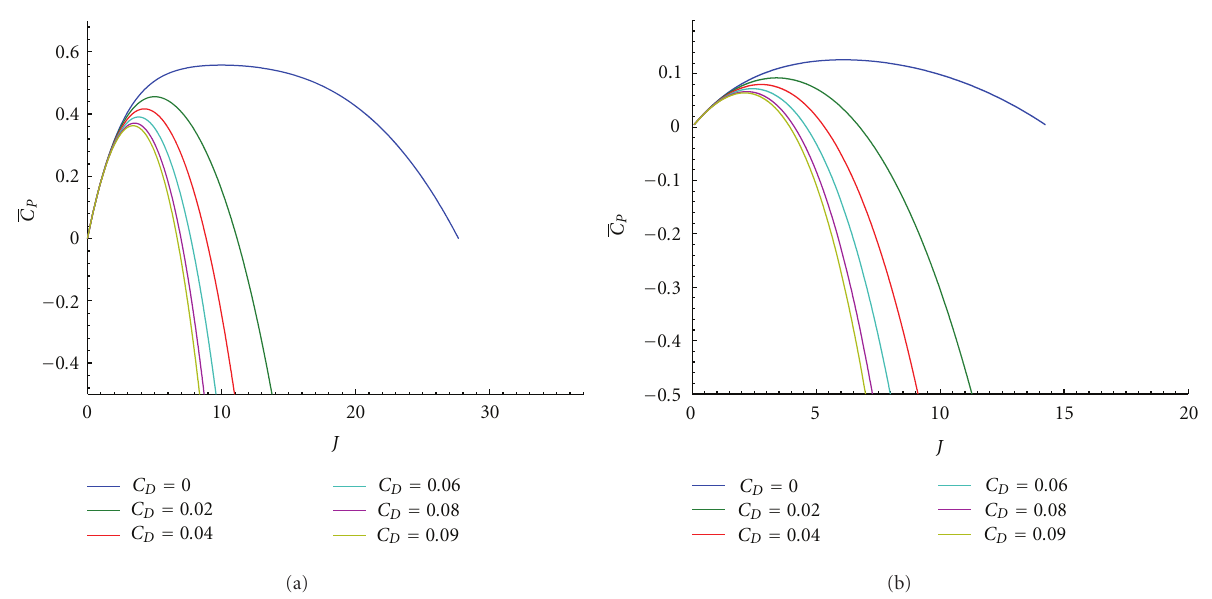
Figure 16: (a) C P versus J for θ = 3 ◦ and γ = 15 ◦ and (b) C P versus J for θ = 3 ◦ and γ = 60 ◦